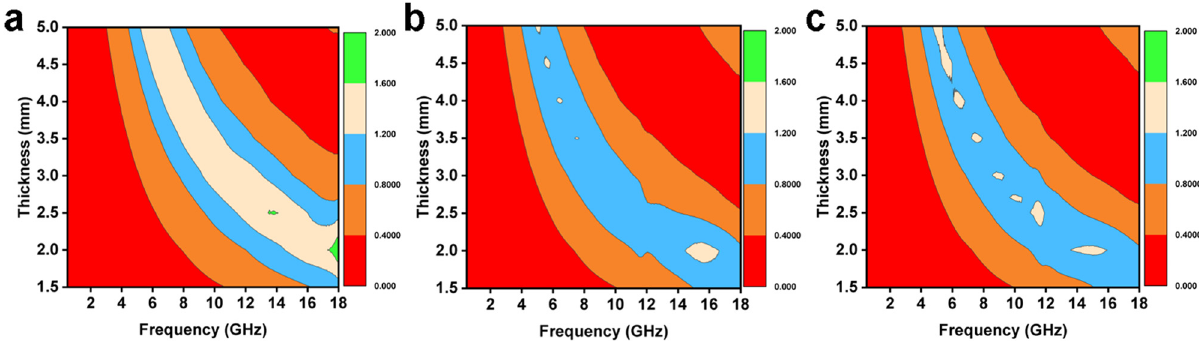
Figure 7: The impedance matching of McM@rGO. | Z in / Z 0 | maps of ( a ) McM@rGO - 400, ( b ) McM@rGO - 600, and ( c ) McM@rGO - 800.